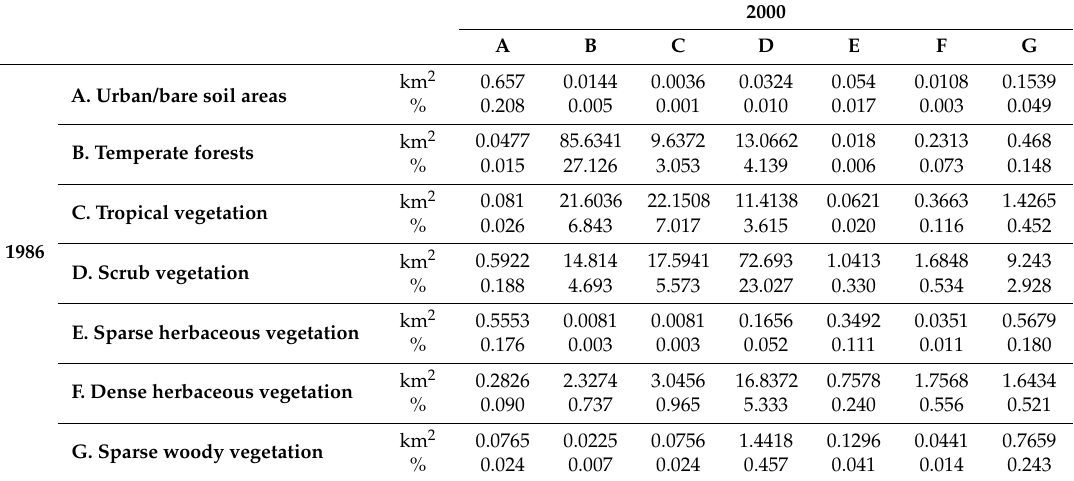
Table 11. Matrix of land use-cover changes from 1986 to 2000, in Natural Protected Area Altas Cumbres (NPAAC). Victoria, Tamaulipas,